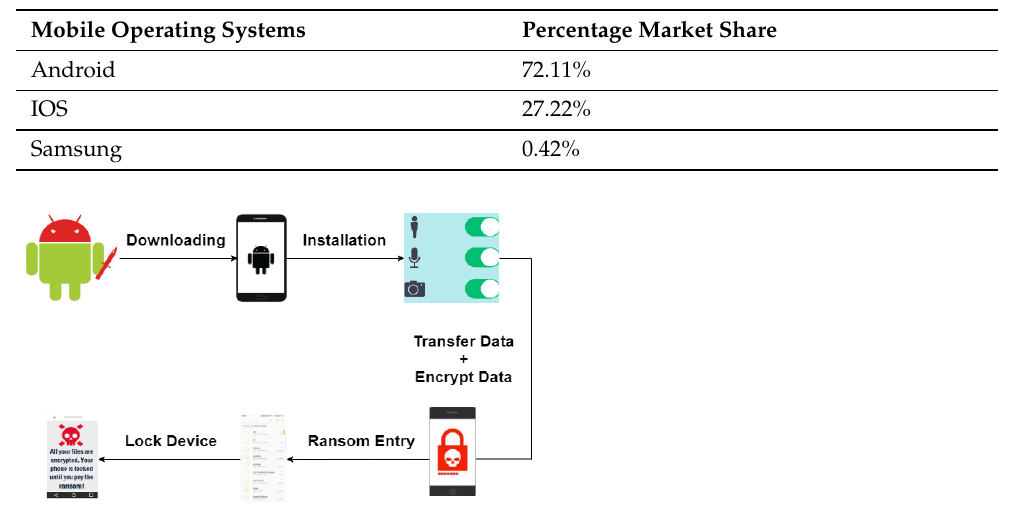
Table 1. The percentage of market share for mobile operating systems.